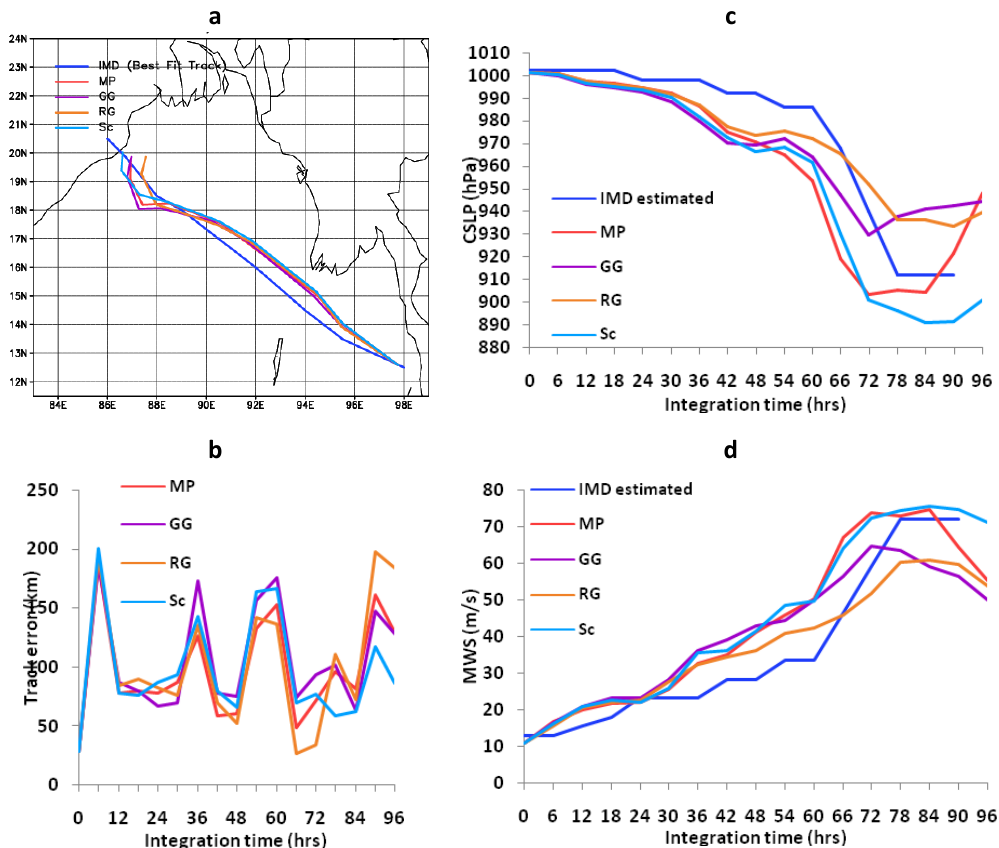
Fig. 11. Same as Fig. 6 but for the experiments with different MPS, namely MP, GG, RG and Sc.